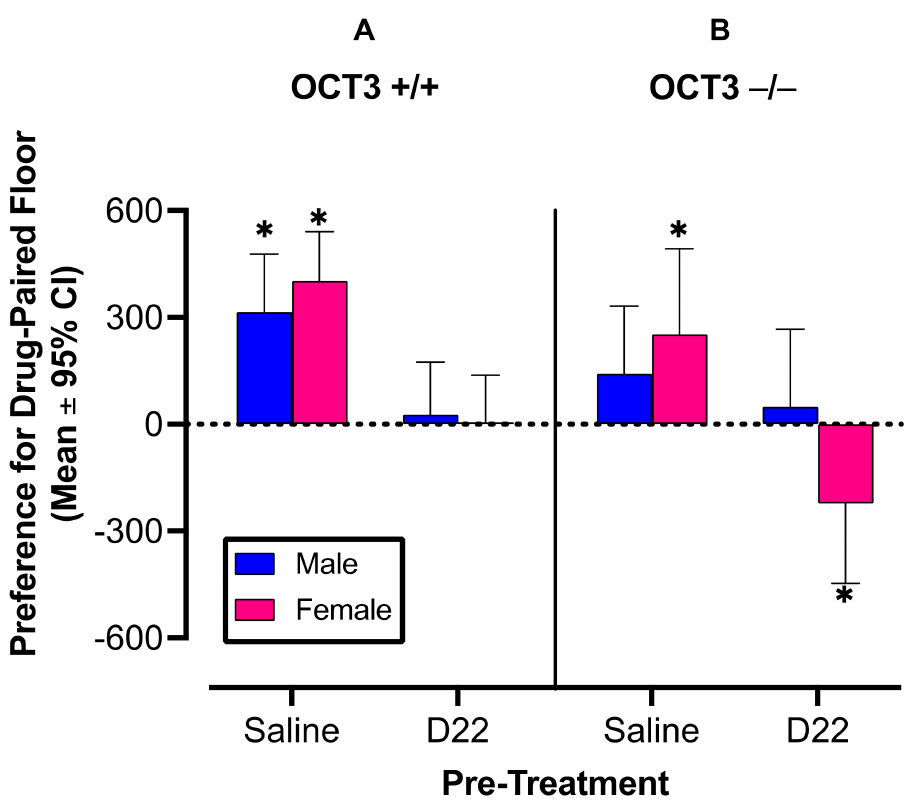
Figure 1. Decynium 22 (D22) prevents amphetamine-induced conditioned place preference (CPP) in organic cation transporter 3 (OCT3) wild-type (+/+) male and female mice ( A ), and in female OCT3 knockout ( − / − ) mice ( B ). Male OCT3 − / − mice do not develop significant CPP for amphetamine. n = 16 per group. Error bars indicate 95% confidence intervals (CI). Asterisks indicate mean values with 95% CI that do not include zero, representing statistically significant place preference (male and female OCT3+/+ and female OCT3 − / − mice) or aversion (female OCT3 − / − mice). * p < 0.05 CPP results with D22 + amphetamine in OCT3 − / − females (Figure 1B, lower